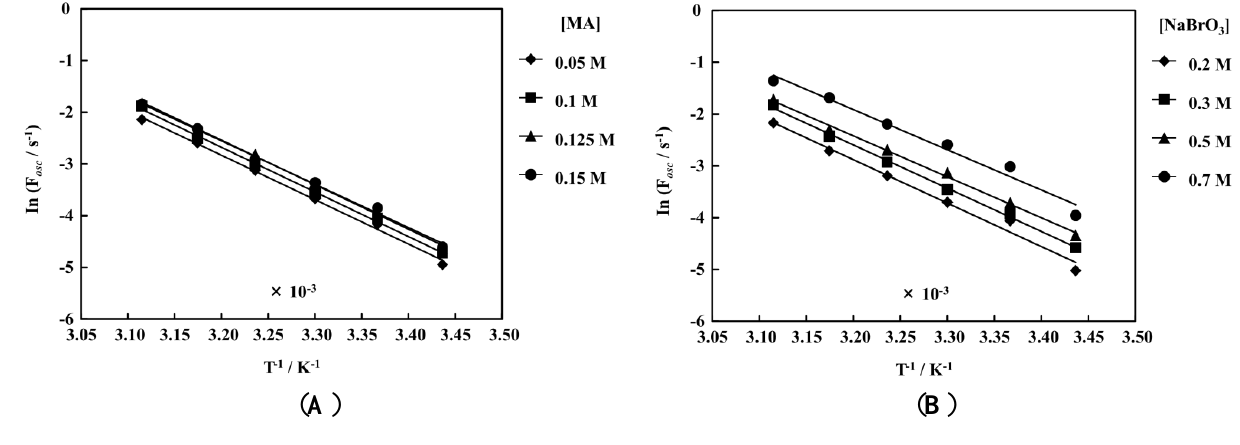
Figure 8. Arrhenius dependence on temperature of self-oscillation for the poly(NIPAAm- co -Ru(bpy) - co -AMPS), oscillating frequency (F osc ), with a fixed concentration of the 3 other two BZ substrates: ( A ) [NaBrO ] = 0.3 M and [HNO ] = 0.3 M; ( B ) [MA] = 0.1 M 3 3 and [HNO ] = 0.3 M; ( C ) [NaBrO ] = 0.3 M and [MA] = 0.1 M; ( D ) Dependence of 3 3